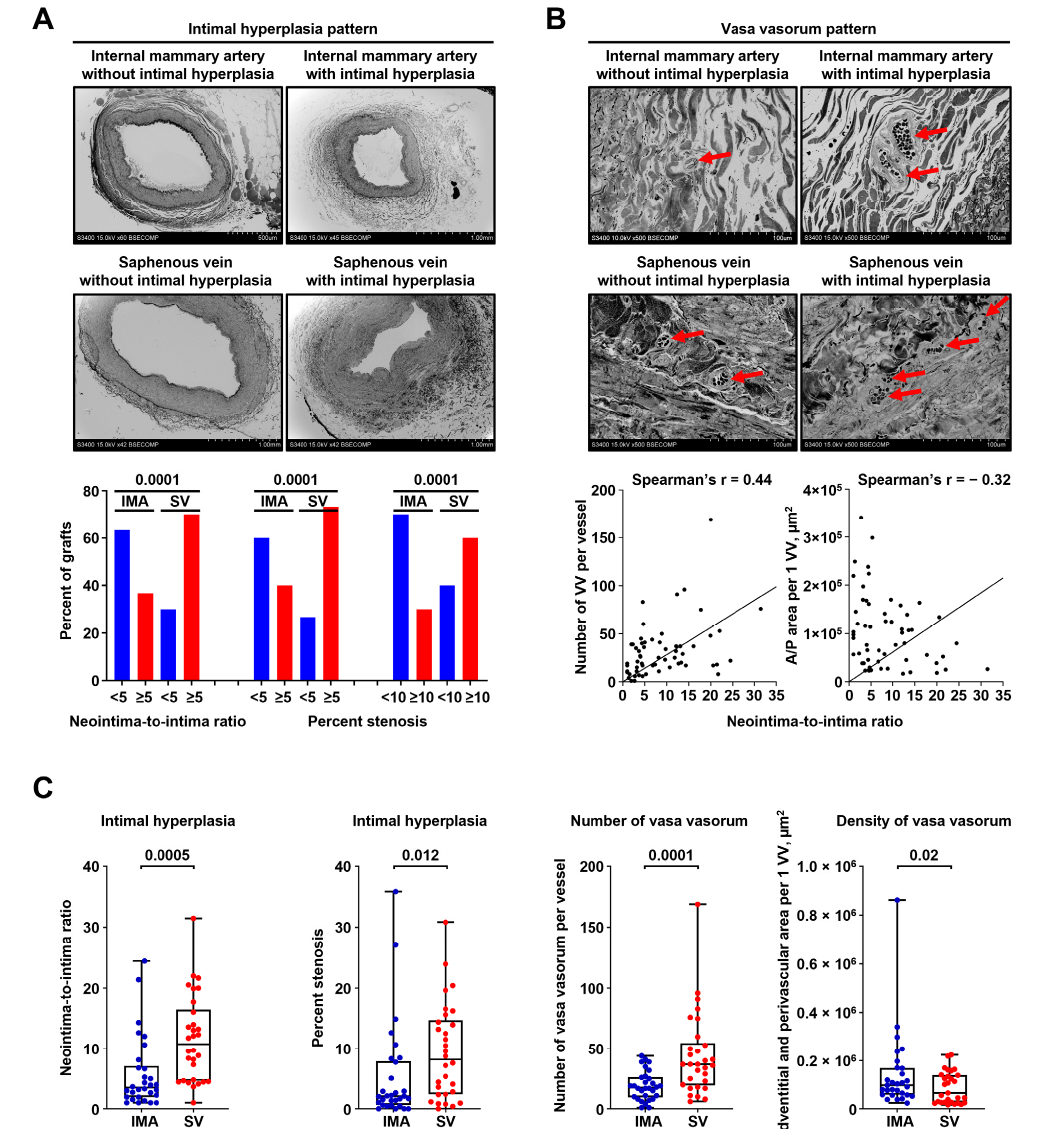
Figure 6. Saphenous veins utilised for CABG surgery frequently suffer from pre-implantation stenosis which correlates with the amount of VV. ( A ) Above: representative images showing pairwise collected conduits for CABG surgery (IMAs, top and SVs, bottom) without (left) or with (right) IH. Note a larger amount of IH in SVs (bottom) than in IMAs (top). EM-BSEM, × 42– × 60 magnification (scale bar: 500 µ m and 1 mm, accelerating voltage: 15 kV). Below: Quantitative analysis of 30 pairwise collected IMAs and SVs. Bar graph, p -values provided above the bars, Pearson’s chi-squared test with Yates’s correction for continuity; ( B ) Above: VV pattern in bypass grafts (IMAs, top and SVs, bottom) without (left) or with (right) IH. Note the higher VV number in both IMAs and SVs with IH (right). Red arrows indicate VV. EM-BSEM, × 500 magnification (scale bar: 100 µ m, accelerating voltage: 15 kV). Below: correlation of VV count and VV density (A/P area per 1 VV, µ m 2 ) with IH expressed as neointima-to-intima ratio, Spearman’s rank correlation coefficient; and ( C ) Quantitative analysis of the samples from ( A , B ). Each dot represents a cross-section of the epoxy resin-embedded blood vessel (one IMA and one SV per patient). Whiskers indicate range, box bounds indicate 25th–75th percentiles, center lines indicate median. p -values provided above boxes, Wilcoxon